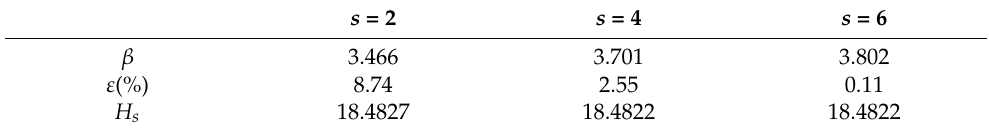
Table 4. Evolution of the estimated reliability index and its Shannon entropy with the variation in s.